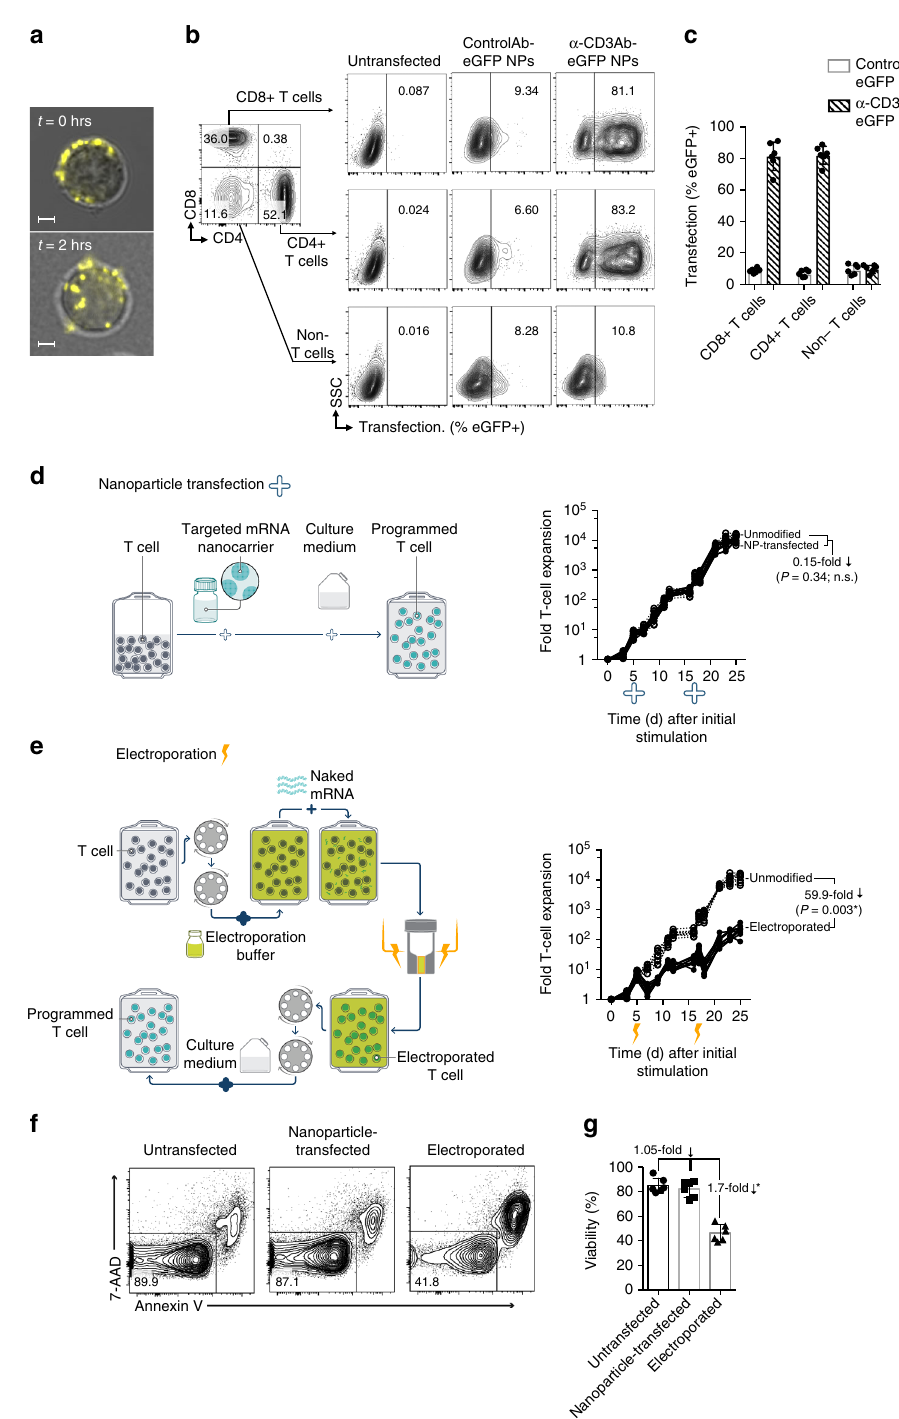
Fig. 2 mRNA nanoparticle transfection choreographs robust transgene expression by lymphocytes. a Primary T-cells were mixed with CD3-targeted polymeric nanoparticles (NPs) carrying Cy5-labeled mRNA. Confocal microscopy establishes that these particles are rapidly internalized from the cell surface. The images are representative of 15 randomly chosen fi elds. Scale bars , 2 μ m. b Flow cytometry of preactivated PBMCs 24h after incubation with CD3-targeted or isotype control antibody-targeted nanoparticles bearing eGFP-encoding mRNA. c Bar graph summarizing transfection ef fi ciencies from three independent experiments conducted in duplicate. d , e Comparison of the effects electroporation and NP gene delivery have on cell expansion. Left panels show the work fl ow for transfection with NPs ( top ) and electroporation ( bottom ). Right panels show the -fold expansion of PBMC cultures from three independent donors treated with stimulatory beads on days 0 and 12. Matched cultures from each donor were not treated, or transfected using CD3/CD28-targeted NPs ( d , right ) or electroporation ( e , right ) on days 5 and 17. Every line represents one donor and each dot re fl ects the -fold T-cell expansion. Pairwise differences between groups were analyzed with the unpaired, two-tailed Student ’ s t test; n.s., non-signi fi cant; *, signi fi cant, n = 3). f Relative viability of NP-transfected and electroporated T-cells. Samples of 2×10 6 activated T-cells per condition were untreated, transfected with NPs, or electroporated. 18h after treatment, cells were labeled with fl uorescent dyes to assess viability. Results from three separate experiments conducted in duplicate are summarized in the bar graph shown in g . Statistical analysis between groups was performed using the unpaired, two-tailed Student ’ s t Test. * P <